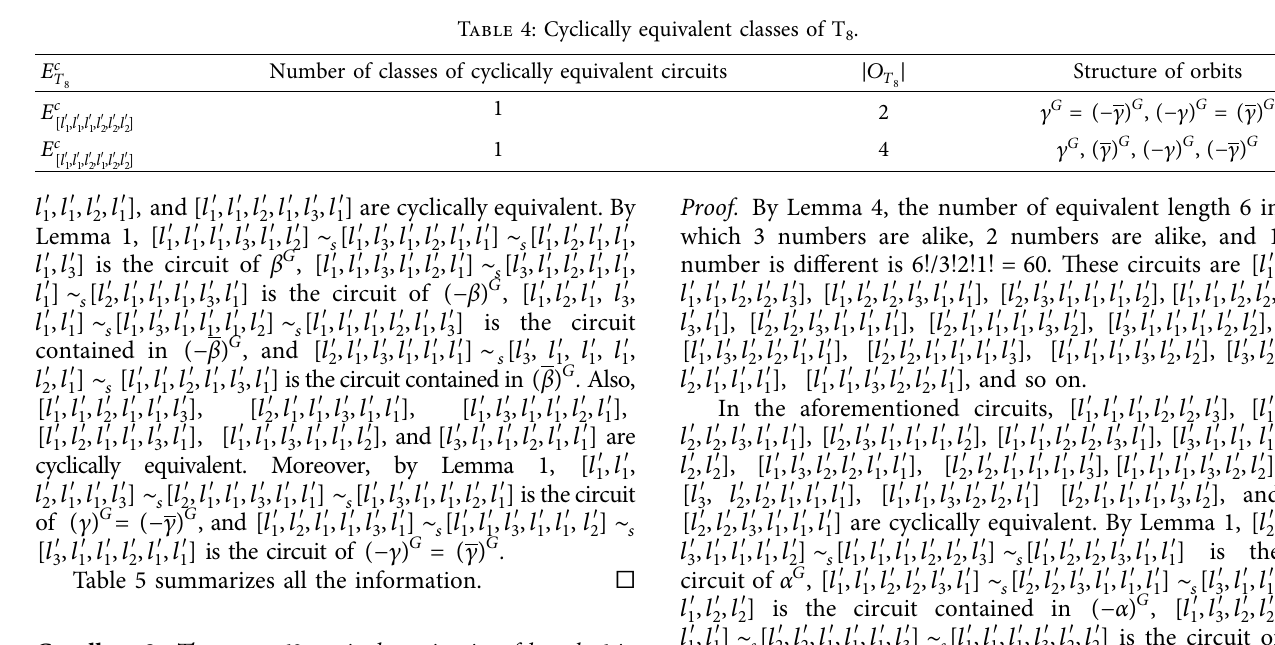
Table 4: Cyclically equivalent classes of T